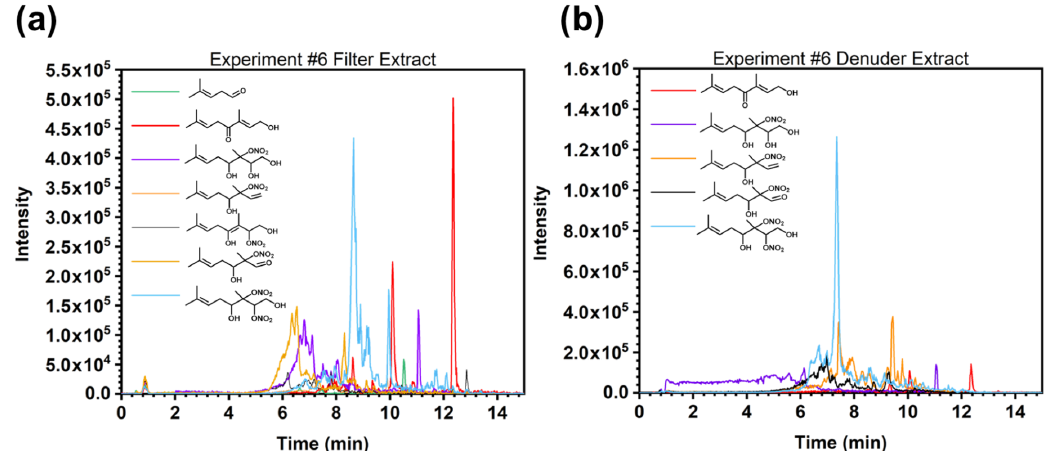
Figure 7. Selected ion chromatograms of expected oxidation products in electrospray (ESI) negative mode for experiment no. 6 in the (a) filter extract and (b) denuder extract. Structures listed are tentative assignments of neutral molecules based on the molecular formula of the selected ions. Actual structures may vary depending on the primary addition of the OH.